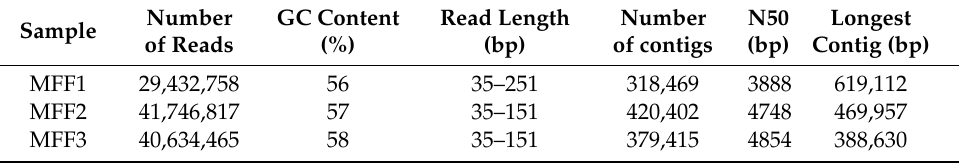
Table 1. Sequencing results for the three metagenomes along with assembly statistics using